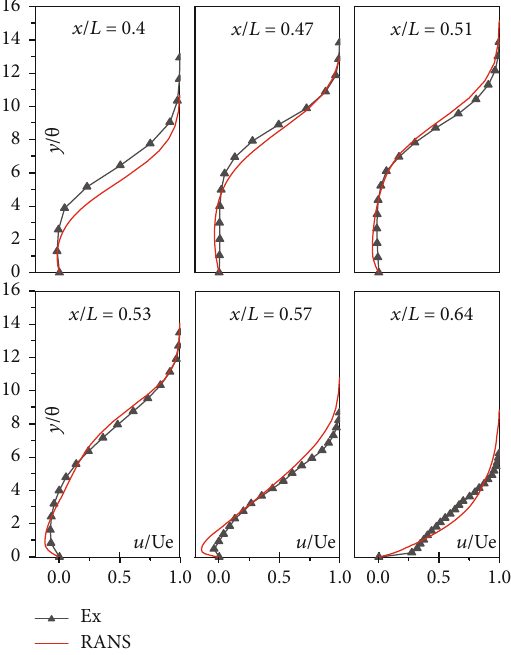
Figure 7: Velocity pro fi le comparison along the plate